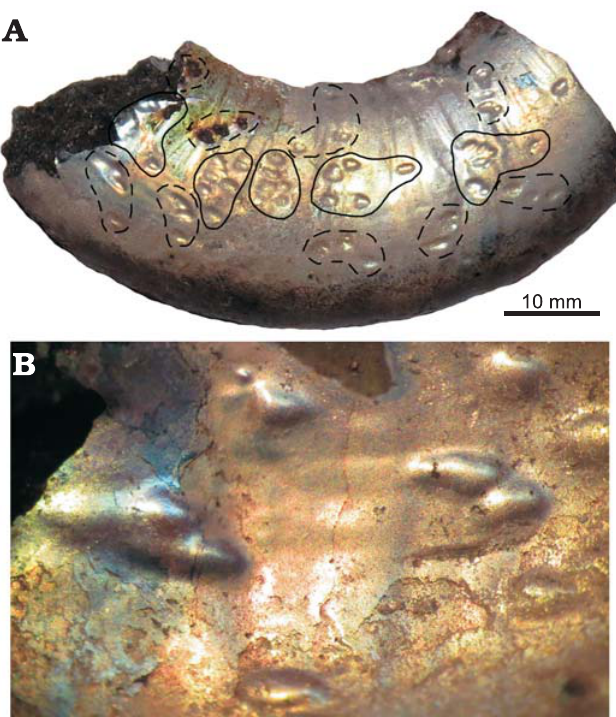
Fig. 12. Clusters of pits on the surface of the craspeditid ammonite Kachpurites fulgens (Trautschold, 1861) shell from the Late Volgian, Kach- purites fulgens Zone, Eganovo ocality, Moscow region, Central Russia, MSU 118/1. A . General view, three clusters which repeatedly occurred on the shell marked by lines: ventro-lateral and dorso-lateral clusters marked by dotted line, mid-lateral cluster marked by solid line. B . Two groups of pits on the anterior ventro-lateral portion of the shell. They are very similar to each other and likely were formed by the same epizoans during the sub- sequent stages of shell